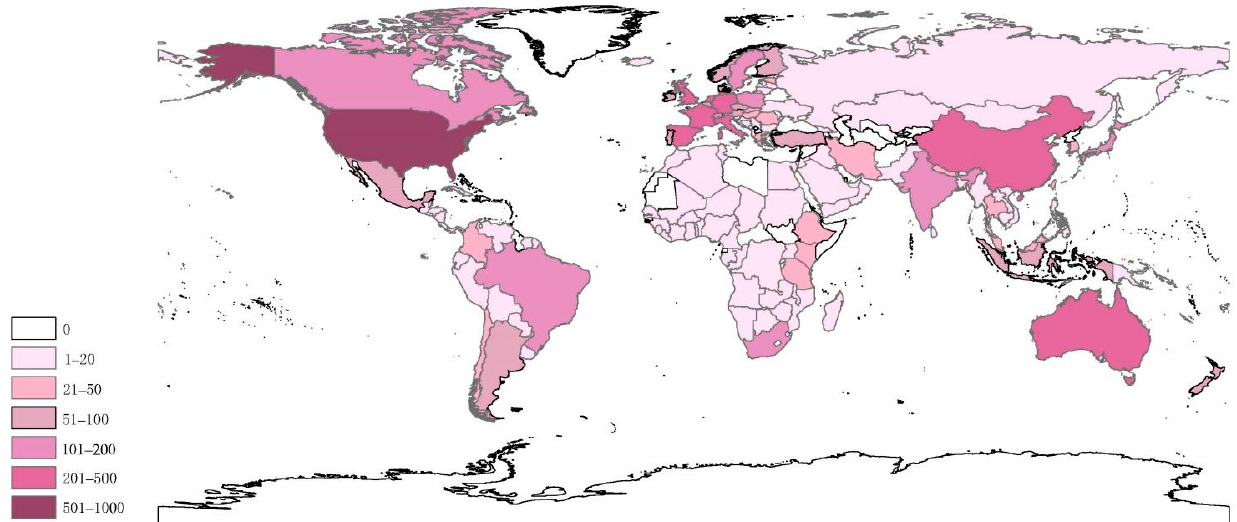
Figure 4. Global geographic distributions of publications during the period from 2006 to 2021. Table 4. Top 10 productive countries or regions during the period from 1990 to 2021.